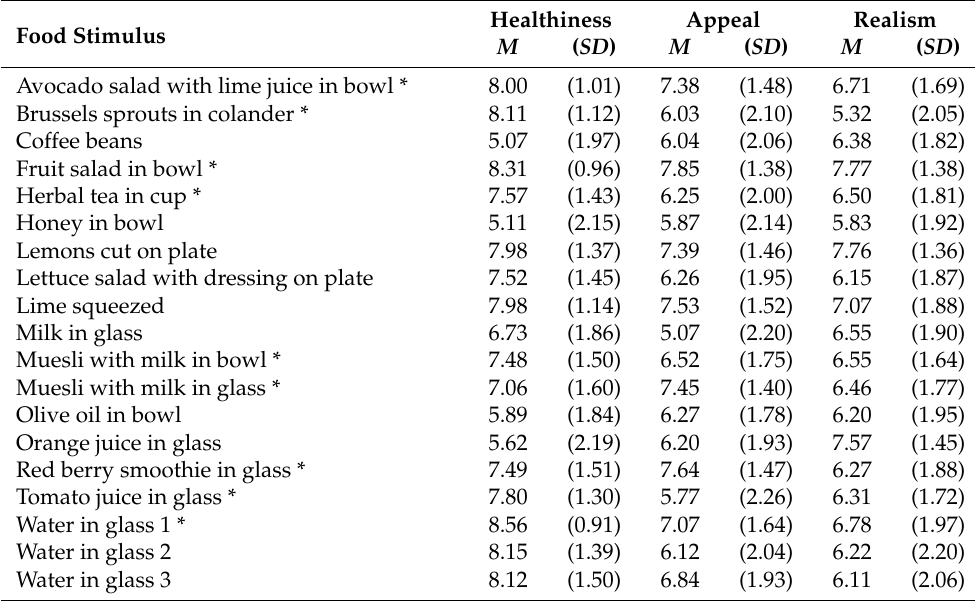
Table A1. Overview of pretest results for the food stimuli used in Study 1 and Study 2a